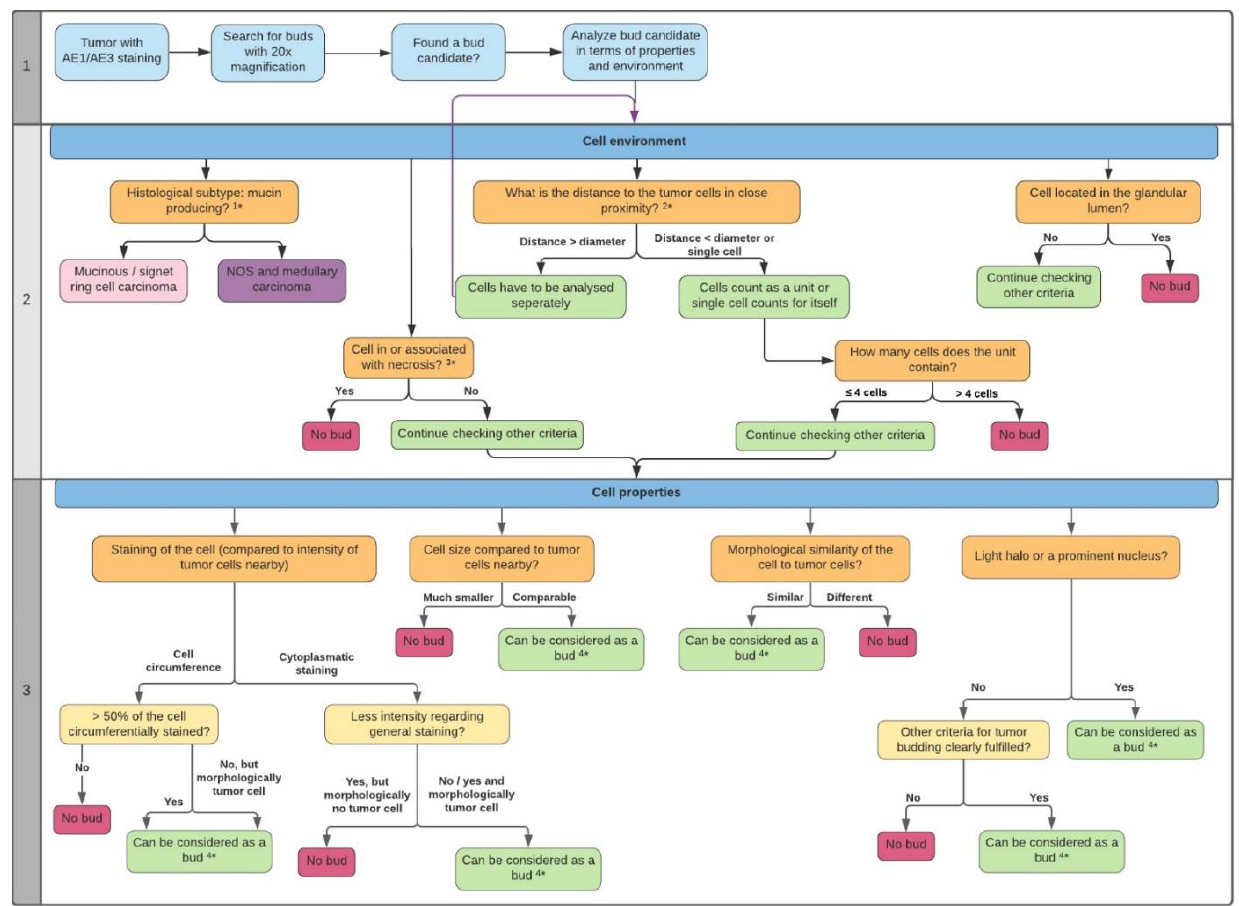
Figure 8. Flowchart to detect tumor buds. In the scheme, all relevant criteria are shown in Sections 1–3 regarding aspects for single cells and bud candidates and for their surroundings nearby. The flowchart was constructed using Lucidchart (2021 Lucid Software Inc., Amsterdam, Netherlands) and using a template for UML activity diagrams. Additional comments are provided in Sections 4.4.2–4.4.4. The footnotes of this scheme are resolved in Sections 4.4.3. and 4.4.4.